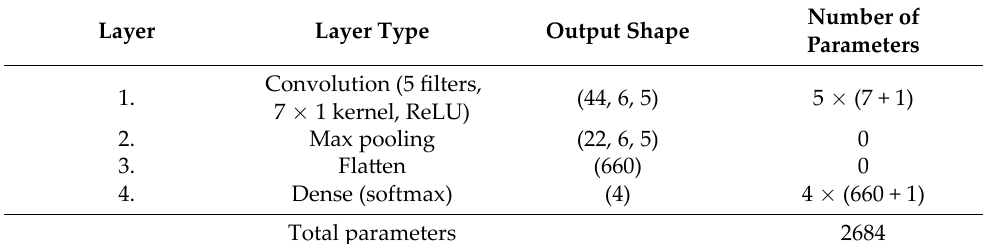
Figure 5. The general structure of the CNN classifier. Table 5. Parameters of the CNN